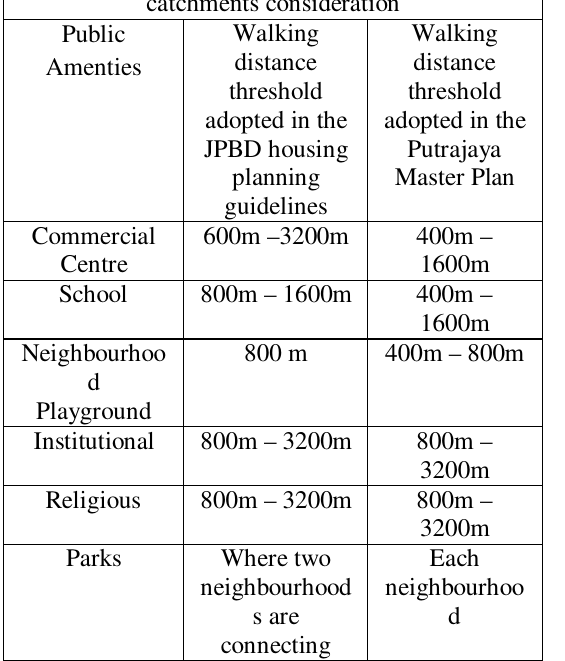
Table 4: Required Walking Distance from center of School to public amenities for walking